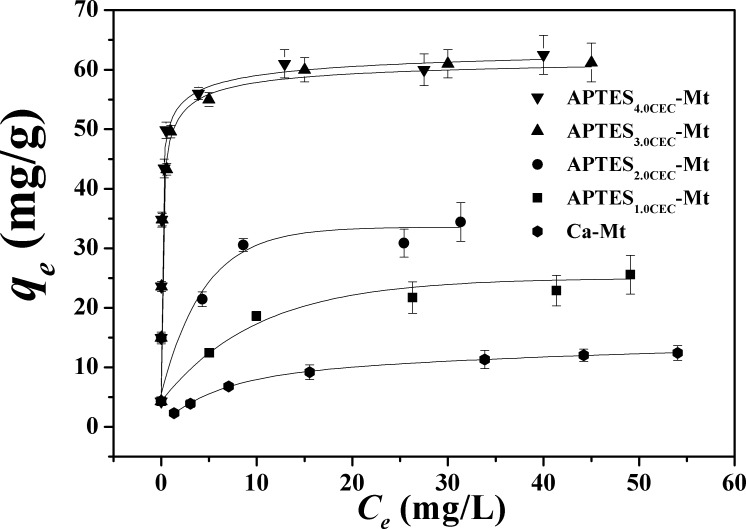
The adsorption isotherm of Co2+ by APTES-Mts.